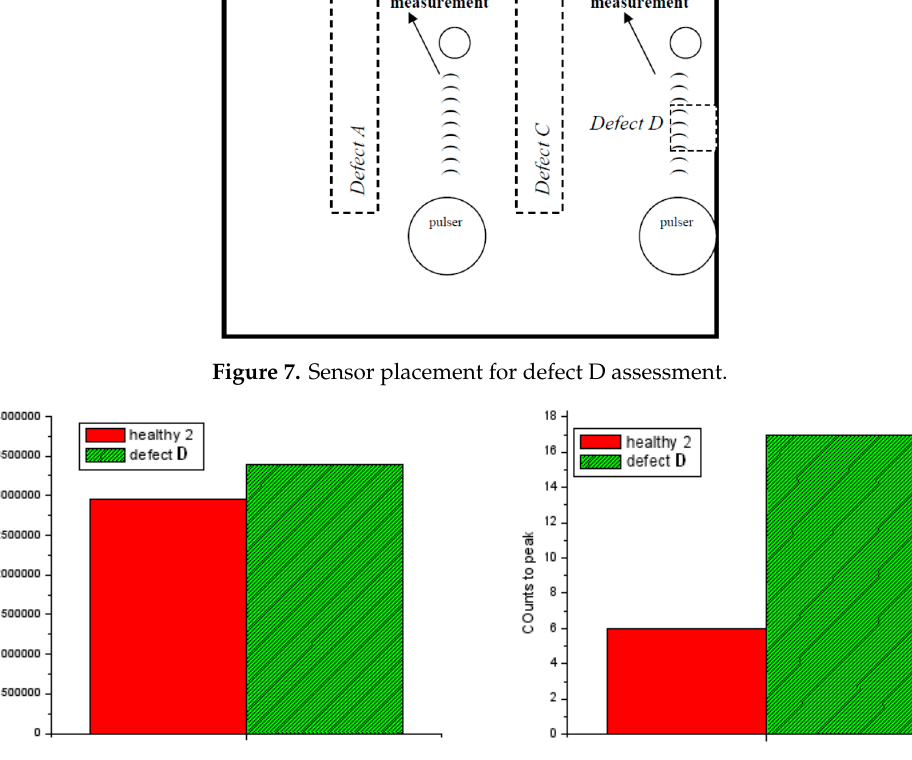
Figure 8. Defect D to non-defective state signal strength and counts-to-peak as extracted from AU waveforms.